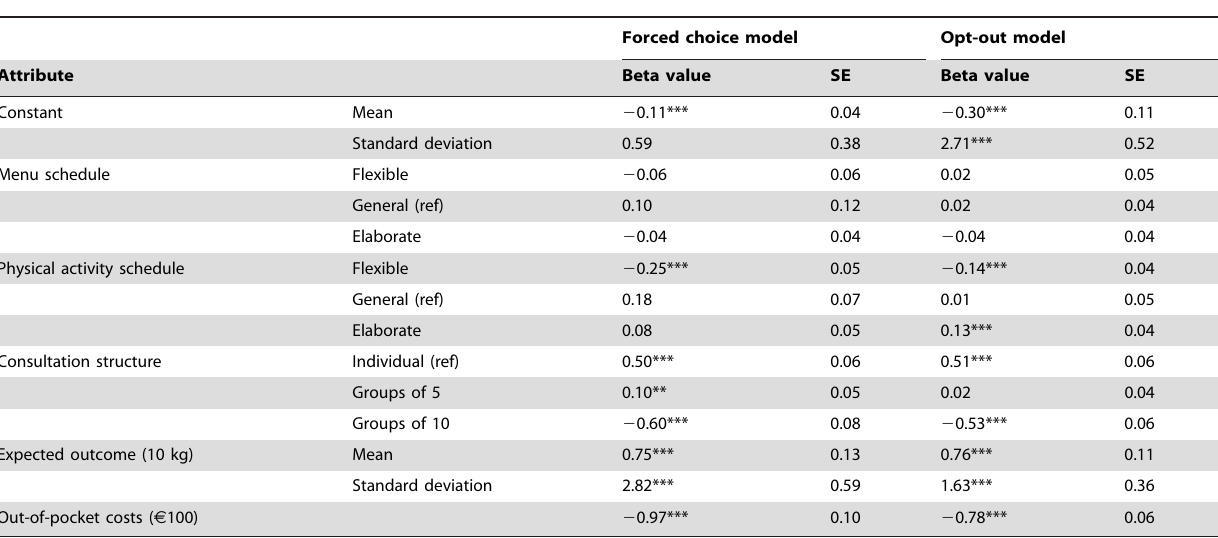
Table 3. Attribute estimates (standard errors) of the MIXL